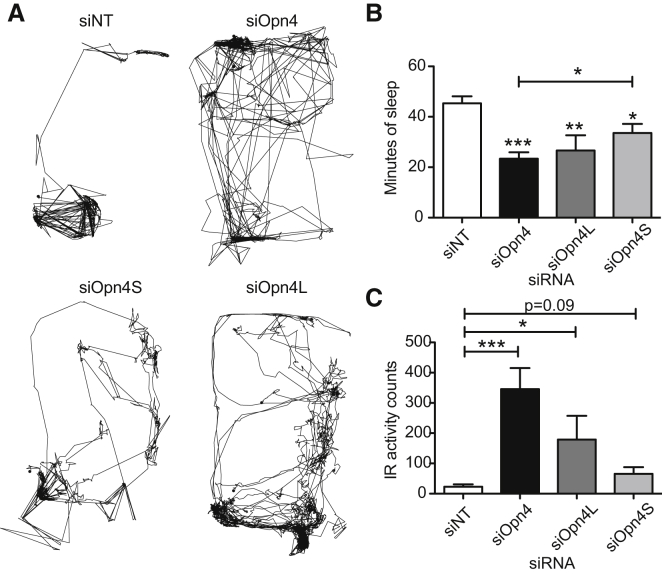
Both Isoforms of OPN4 Mediate Sleep Induction(A) Animals were given bilateral siRNA (siNT, siOpn4, siOpn4S, and siOpn4L) injections and, 4 days later, given a 1 hr light pulse at ZT14, during which videos were recorded and analyzed. The traces show activity patterns during the light pulse of individually housed mice receiving siRNAs as indicated. siNT-injected animals restricted their movements to their nest, where they spent the majority of time sleeping. The Opn4 knockdown animals showed markedly decreased levels of sleep.(B) Total sleep levels (measured as bouts of >40 s immobility) were measured [21] during the course of the light pulse. Opn4 knockdown animals show severely attenuated sleep induction during the light pulse (23.38 ± 2.5 min versus 45.34 ± 2.8 min; n = 10; p < 0.0001). Opn4L and Opn4S knockdown animals also showed reduced levels of sleep (26.65 ± 6.0; n = 10; p < 0.01 and 33.58 ± 3.6; n = 10; p = 0.02).(C) Locomotor activity during the light pulse as measured via passive infrared recordings (PIR) for the same animals as above showing attenuated reductions in the case of Opn4 and Opn4L knockdown (95.4% ± 30.7% and 35.4% ± 11.9% versus 7.4% ± 4.1% for siNT, respectively). Locomotor activity as measured by PIR during the first 10 min of the light pulse to compare with Figure 3 are provided in Figure S3C, and activity during the hour preceding the light pulse shows no significant differences across the groups as indicated in Figure S3D. ∗p < 0.05, ∗∗p < 0.01, ∗∗∗p < 0.001; one-way ANOVA with Tukey’s post-tests. Error bars represent the SEM.See also Figures S1–S3.